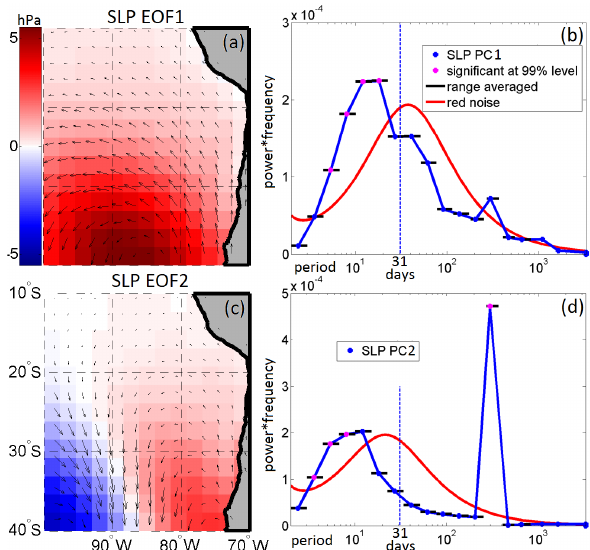
Fig. 6. Dominant EOF/PC’s of SLP data. Data are weighted by the square root of the cosine of the latitude so that equal areas receive equal variance weighting independent of latitude. (a) is the spatial EOF1 pattern of filtered SLP data, and the units are the amplitude of SLP associated with a 1 standard deviation variation of PC1. Vec- tors represent composite difference (see Sect. 4.2.1) surface winds, longest vectors are 5ms − 1 . (b) is the power spectrum of PC1 of the unfiltered SLP data (for all analysis the filtered PC1 is used). 31 days is the cutoff period for the filter. “Range averaged” indicates the range of periods averaged to get each point. The ”red noise” spectrum is the null hypothesis for the significance of each point, computed using the autocorrelation of the PC at a lag of 1 day. (c) is the EOF2 pattern presented in the same manner as (a) and (d) the power spectra of PC2 of unfiltered SLP data.